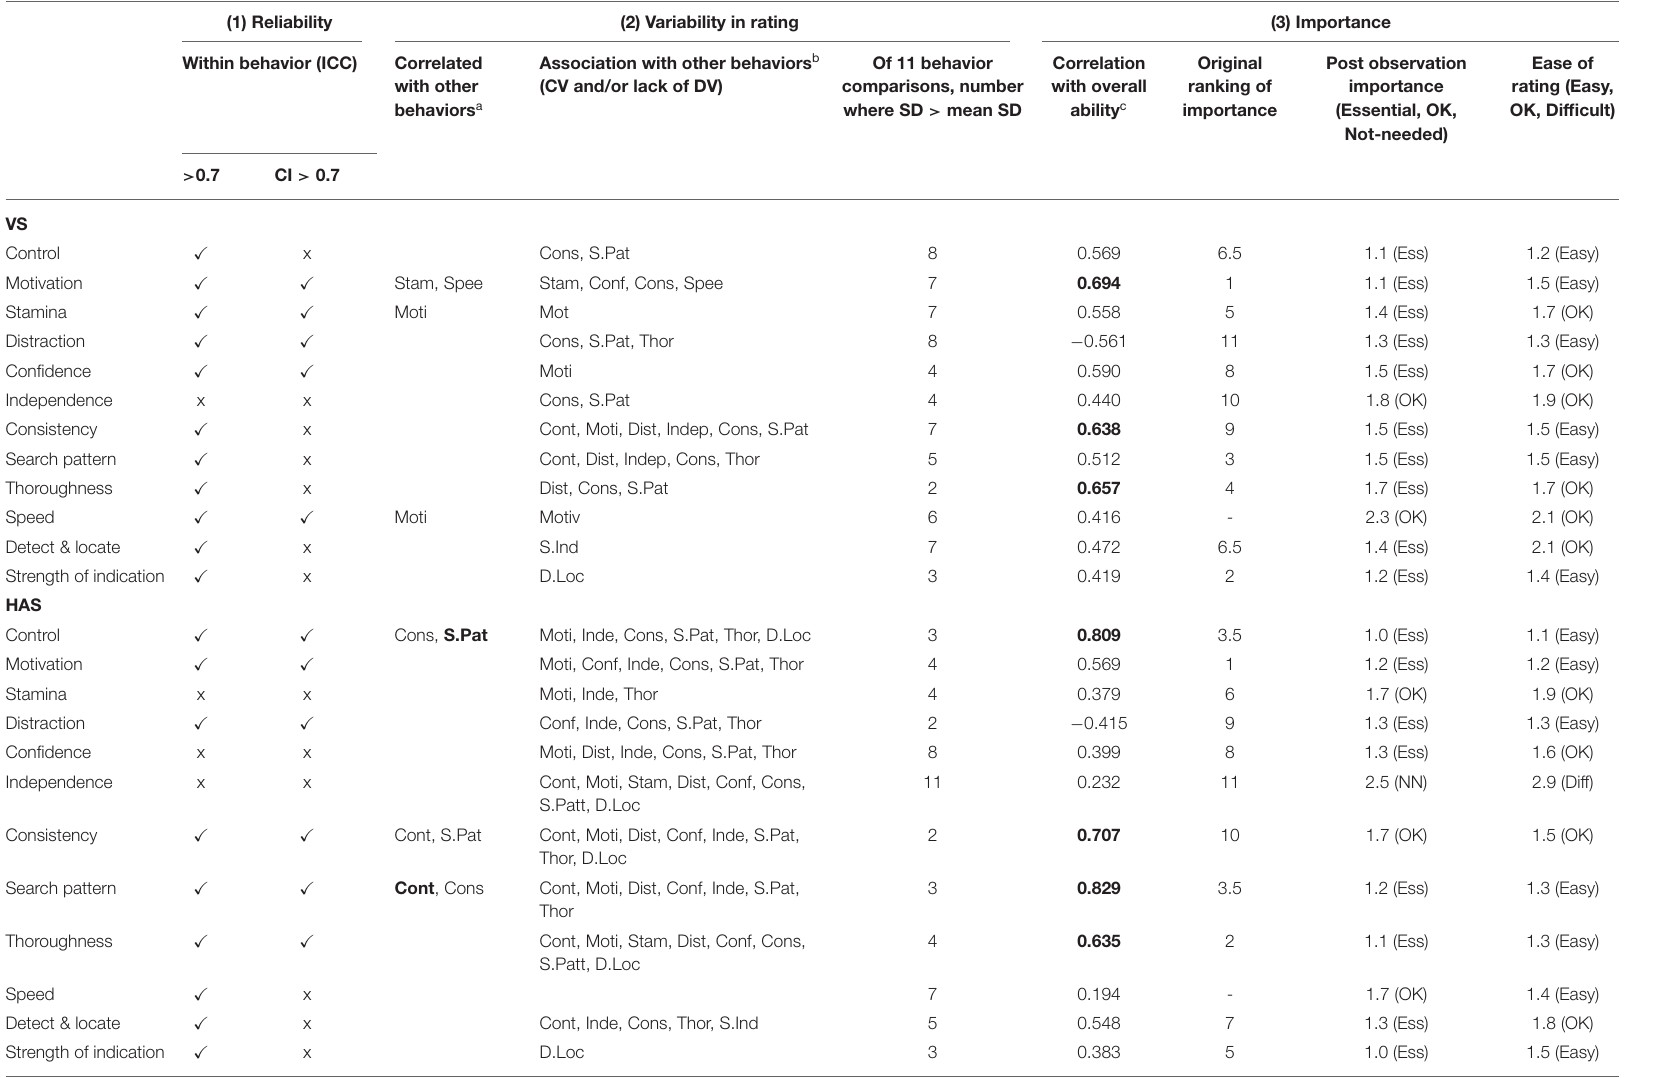
TABLE 4 | Summary table for outcomes of evidence-based 3-step methodology for rating scale development. (1) Reliability (2) Variability in rating (3)